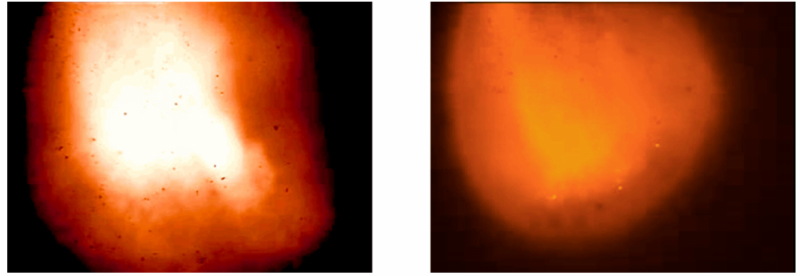
Figure 8. A few low-quality images of the burden